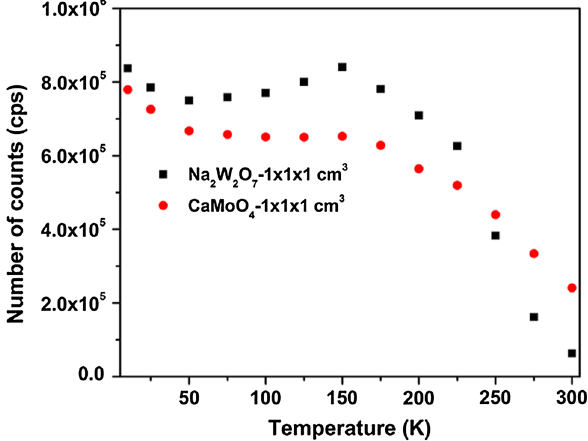
Fig. 7 LuminescencelightyieldscomparisonofNWOandCMOcrys- tal at different temperatures, using a 280-nm-wavelength LED excita- tion